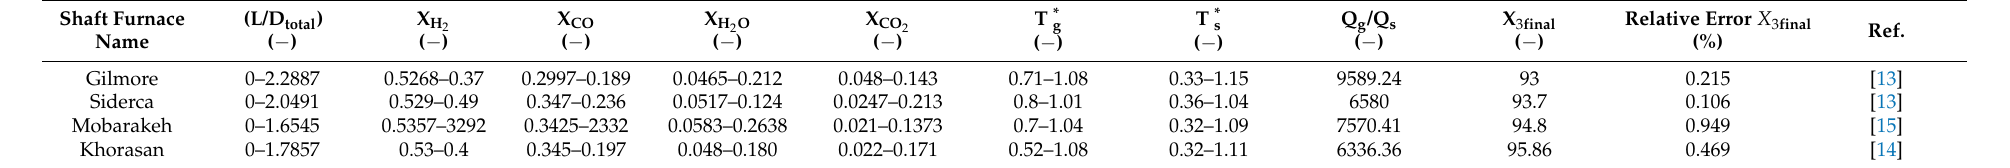
Table 3. Model parameters range for the current